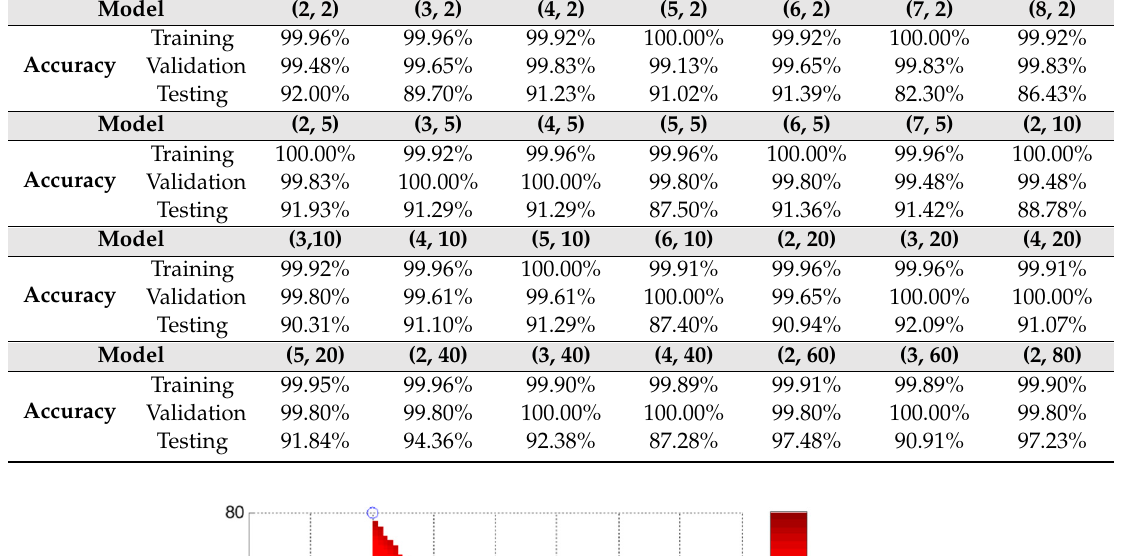
Table 3. The classification accuracy comparison results for each trained model.